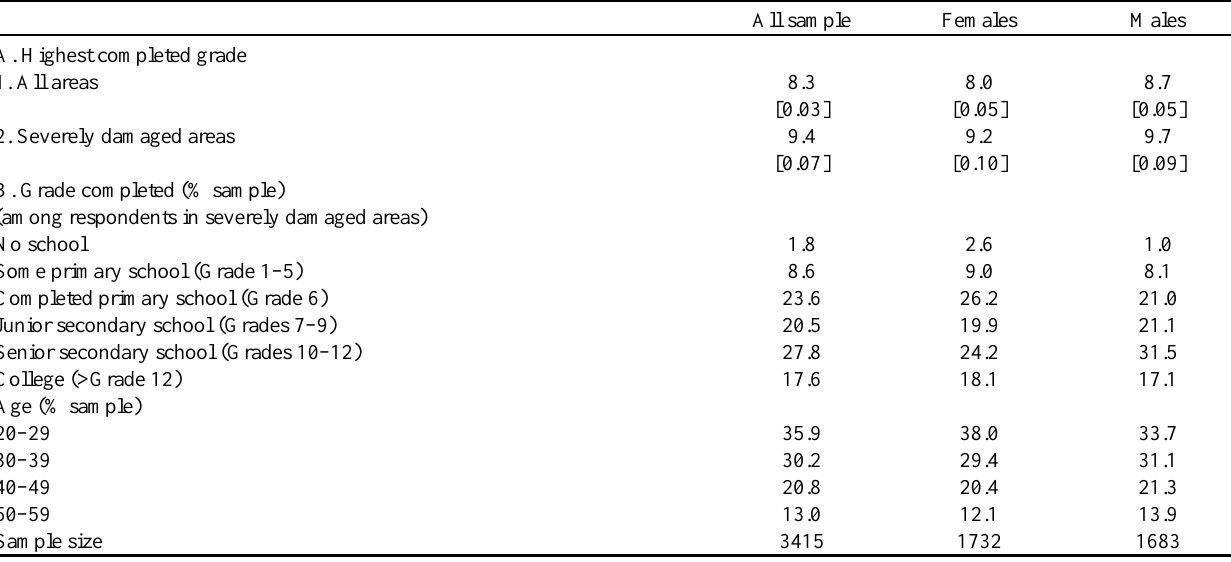
Table 1. Distribution of age and education